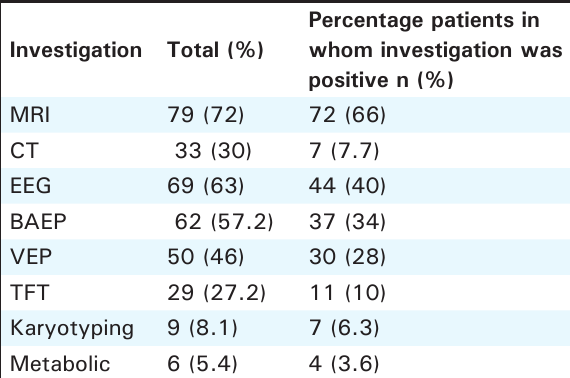
Table 3. Investigation done and their